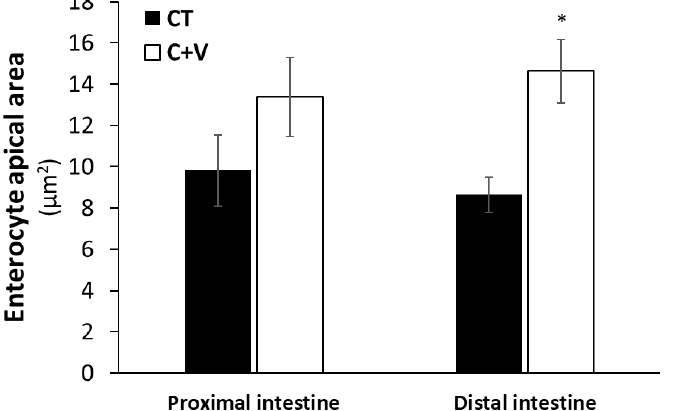
Figure 4. Comparative SEM micrographs from the proximal ( A ) and distal ( B ) intestinal regions of juvenile C. labrosus fed the control (CT) or C. fusca + V. proteolyticus (C + V) diets for 90 days. (bar: 5 µm).